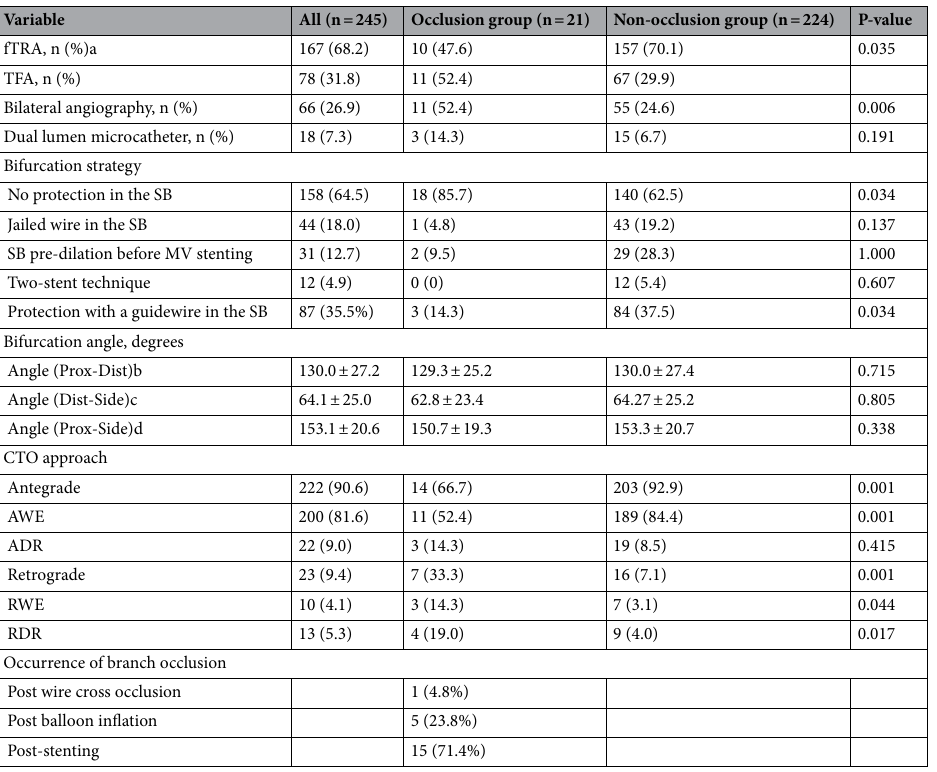
Table 3. Procedural characteristics. The data are shown as the number (percentage) or as the mean and standard deviation as appropriate. (a) The arterial approach was classified as fTRA (unilateral or bilateral radial) or TFA (unilateral femoral, bilateral femoral, or combined radial and femoral). (b) Angle (Prox-Side) denotes the angle between the proximal MV and SB. (c) Angle (Dist-Side) denotes the angle between the distal MV and SB. (d) Angle (Prox-Dist) denotes the angle between the proximal and distal MV. AWE antegrade wire escalation, ADR antegrade dissection re-entry, fTRA fully transradial approach, RWE reversal wire escalation, RDR retrograde dissection re-entry, SB side branch, TFA transfemoral